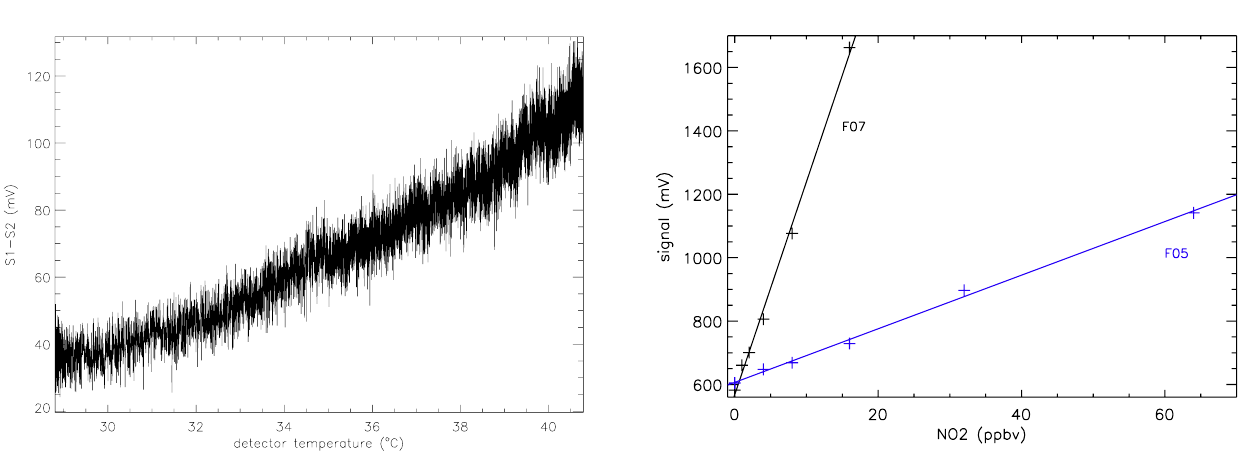
Fig. 6. The difference S1–S2 between the signals measured by the seeing and blind detector arrays, using water and ambient air, as a function of the detector temperature. The signal represents the offset O in Eq. (4), for which the NO 2 measurements need to be corrected.